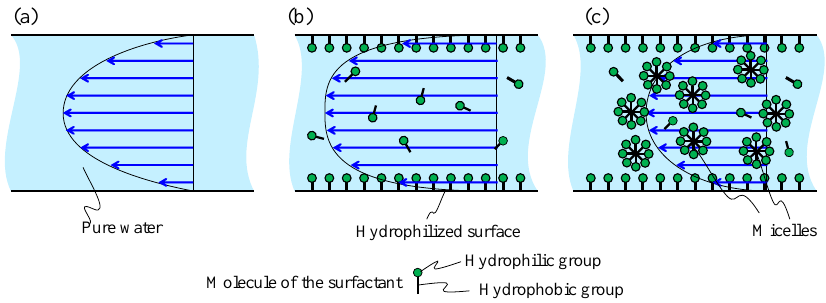
Figure 2. Flow patterns under different liquid conditions: ( a ) pure water, ( b ) water under a surfactant, and ( c ) water under a surfactant with numerous